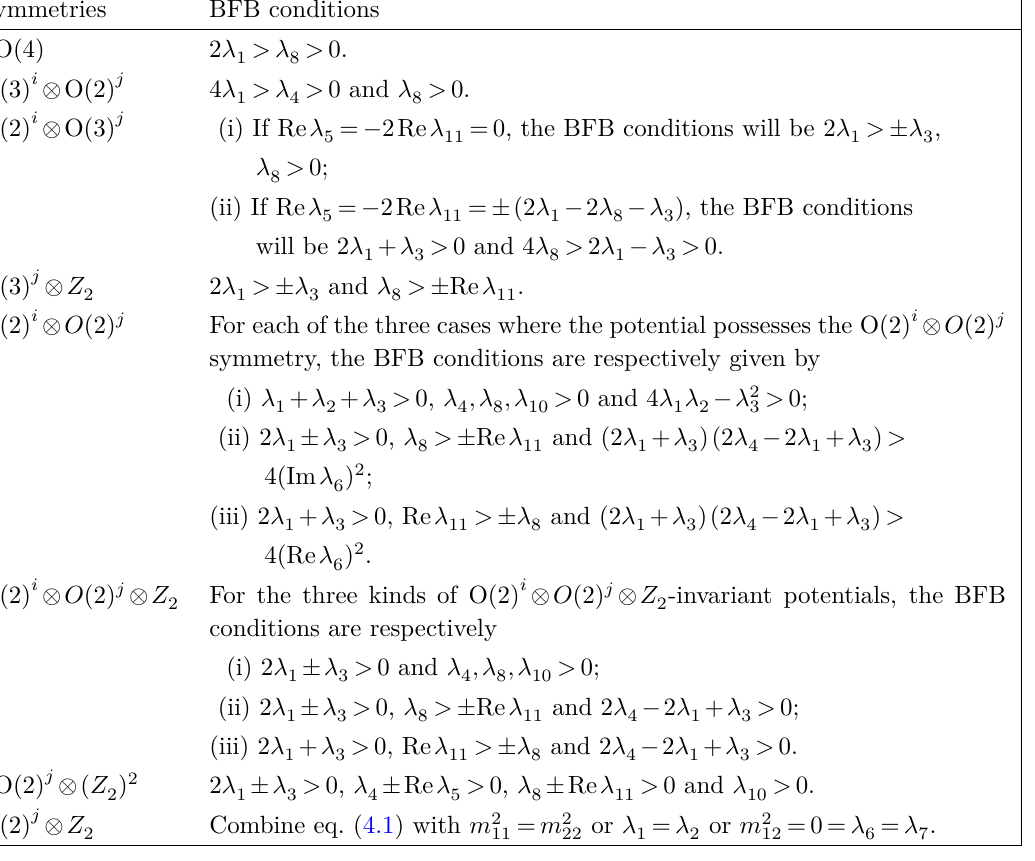
Table 1 . The bounded-from-below (BFB) conditions for the pure-triplet potentials with specific accidental